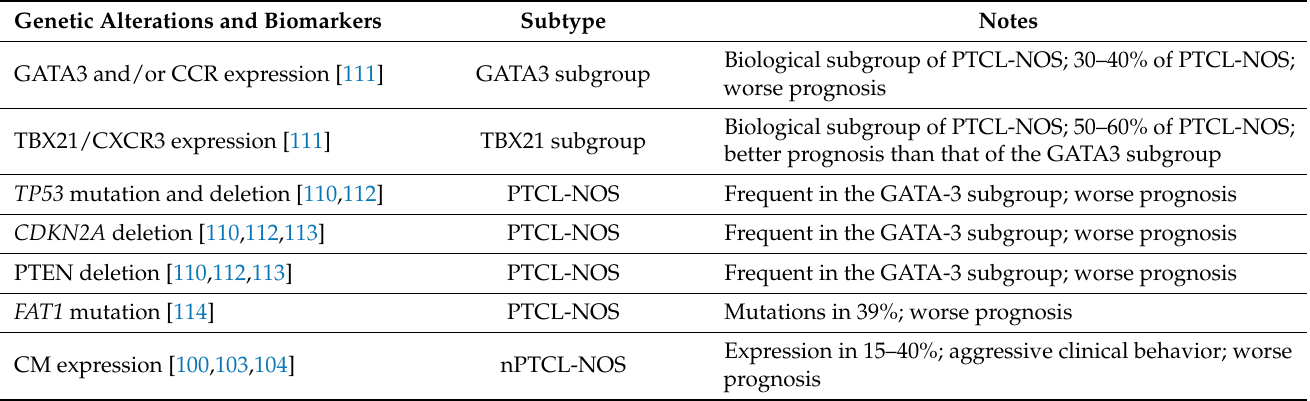
Table 5. Recurrent genetic alterations and key biomarkers of